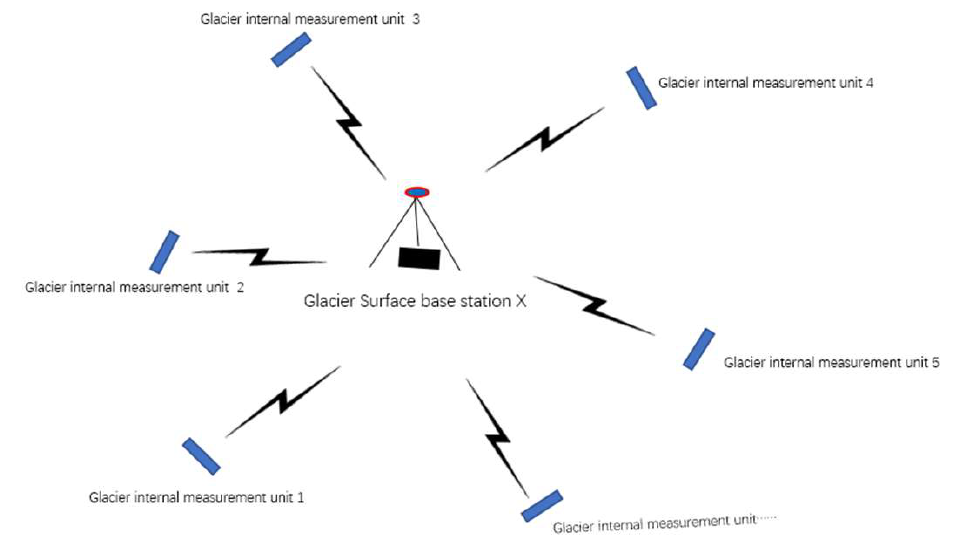
Figure 5. Schematic depiction of the star topology for a